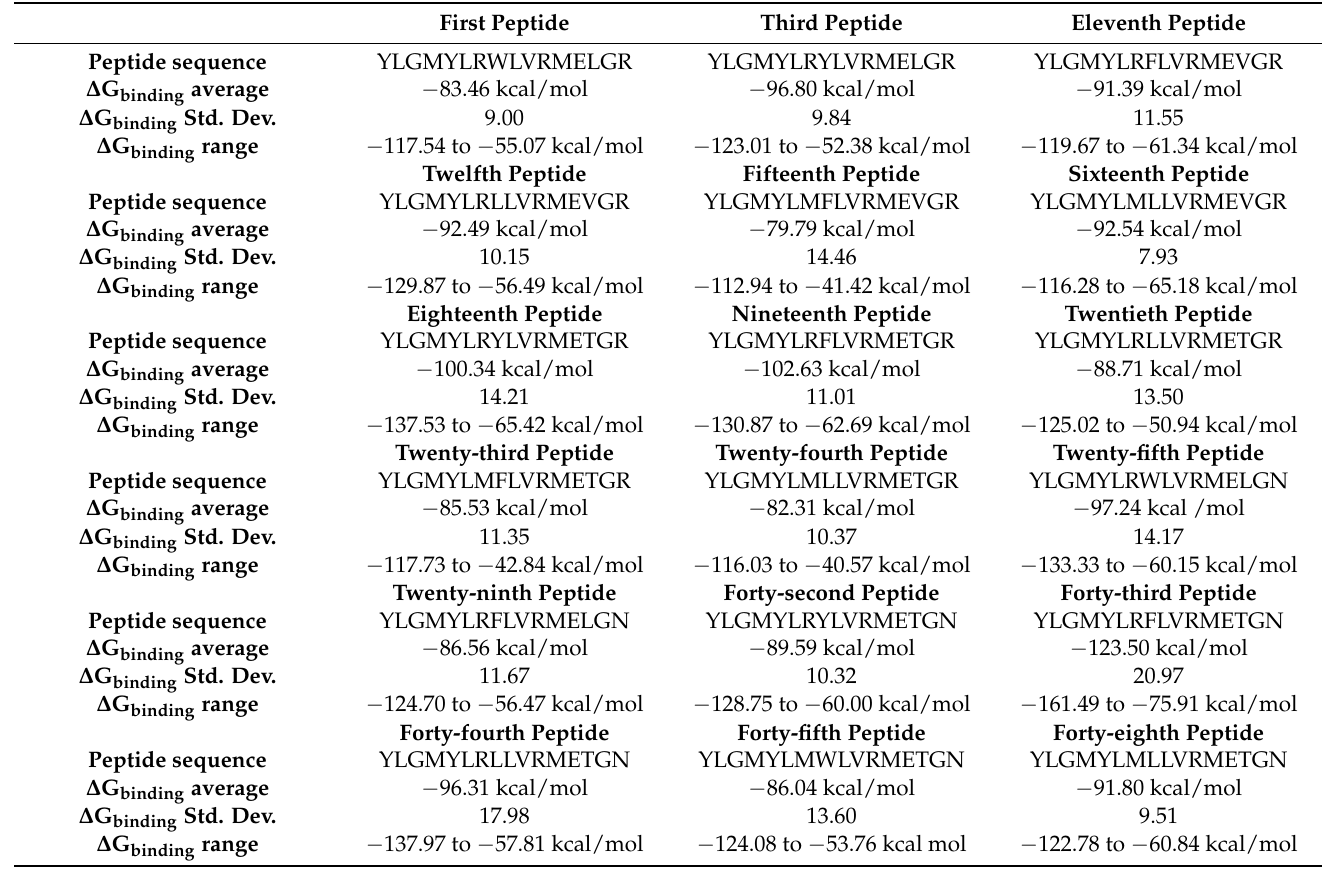
Table 8. MM-GBSA calculation results based on MD simulations of 3 10 -HBS combinatorial peptides not misfolded during the simulations in complex with Ras protein, and with ∆ G binding values lower than the reference one ( − 79.70 kcal/mol).